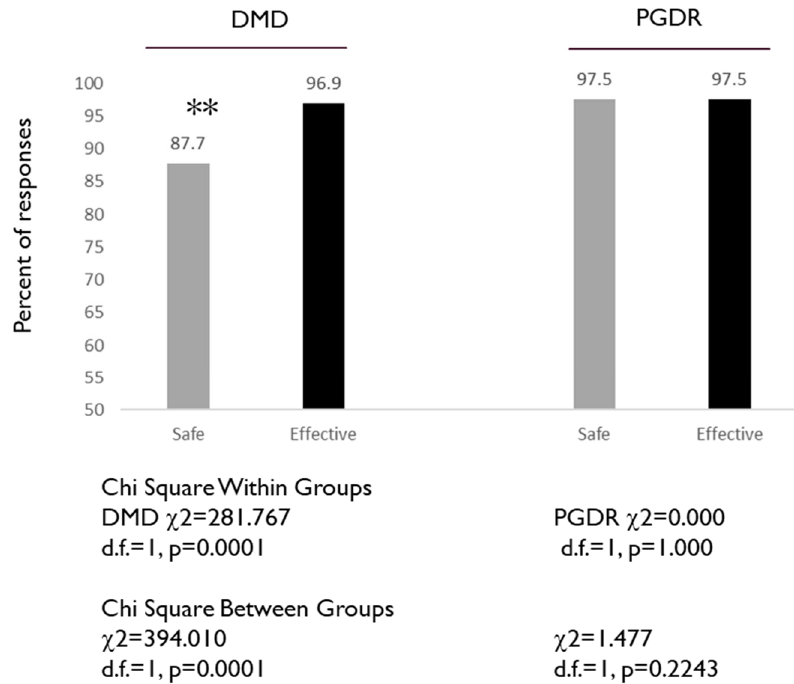
Figure 1. Assessment of DMD and PGDR responses to specific questions: Vaccines are generally safe, and Vaccination is generally effective. DMD students exhibited significantly lower percentages of agreeing that vaccines are safe (87.7%) versus effective (96.9%) p = 0.0001, while no differences were observed among the PGDR (97.5%), p = 1.000. Note:** indicates statistically significant differences.